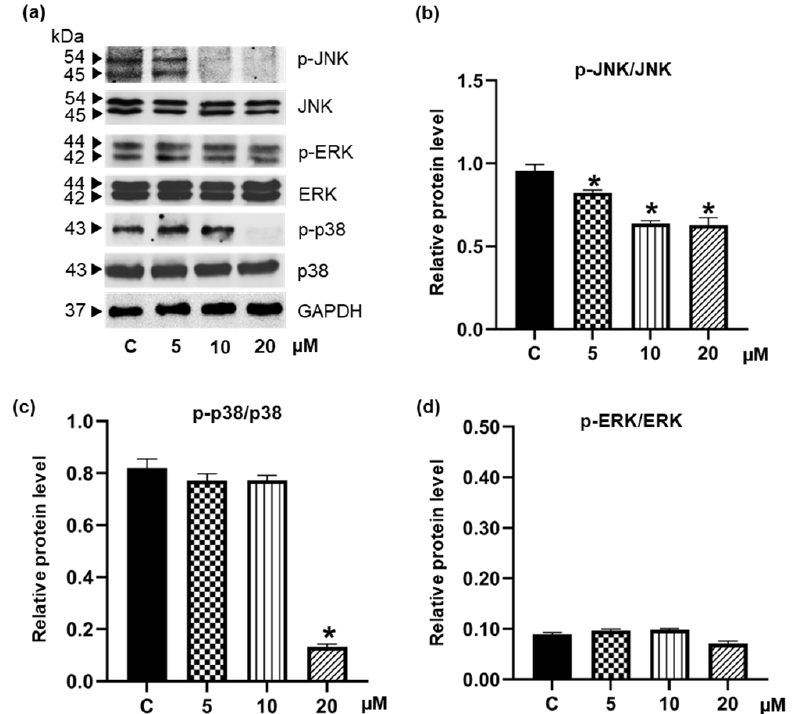
Figure 7. MAPK signals modulated by pinostrobin. ( a ) After induction into mature adipocyte for 48 h, the expression of MAPK signaling molecules, including JNK, ERK, and p38, was detected via Western blot analysis. ( b ) Treatment with low concentration of pinostrobin (5 µ M) significantly downregulated the level of p-JNK/JNK, while ( c ) a dramatic decrease of p-p38/p38 was observed only in the presence of 20 µ M pinostrobin. ( d ) Pinostrobin did not alter p-ERK/ERK levels in differentiated 3T3-L1 cells. Data represent the mean ± SD. * p < 0.05 compared with vehicle control cells (C) treated with 0.5% DMSO.